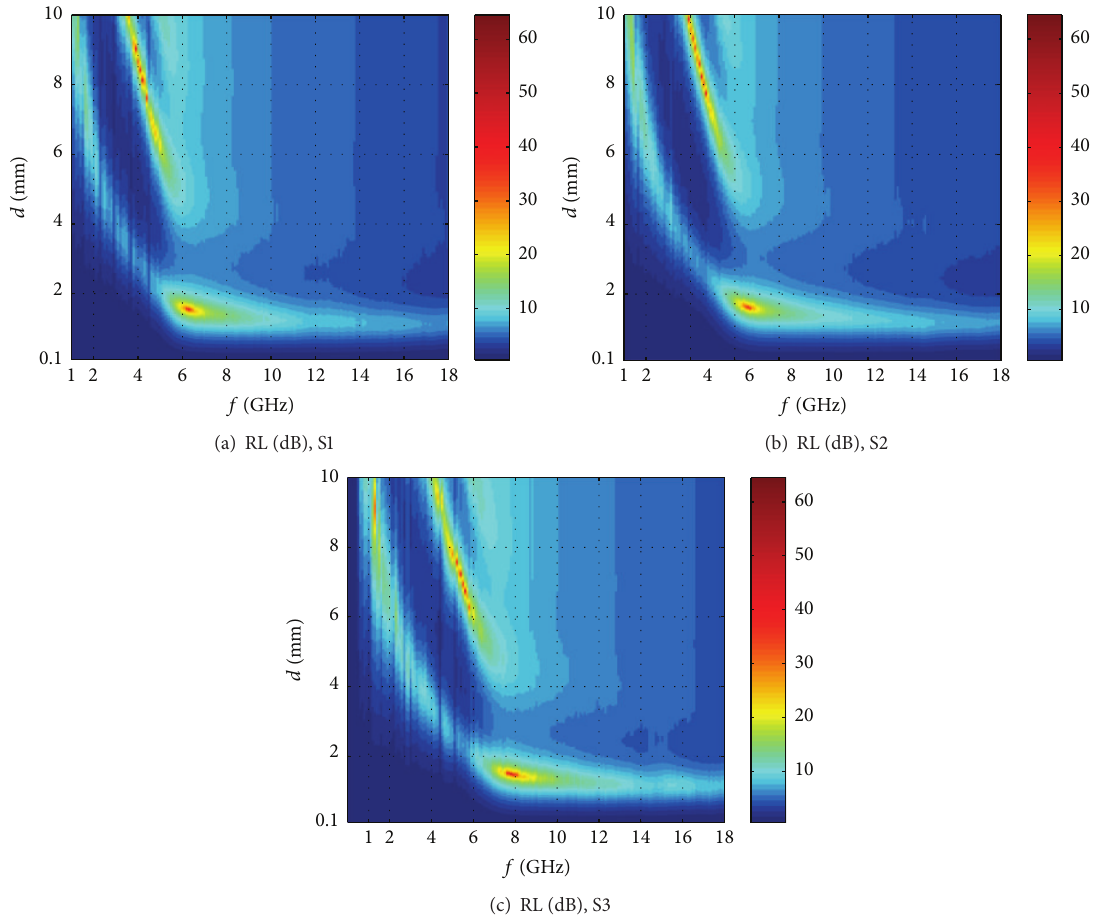
Figure 6: Return losses RL (𝑓,𝑑) of metal-backed (a) S1, (b) S2, and (c) S3